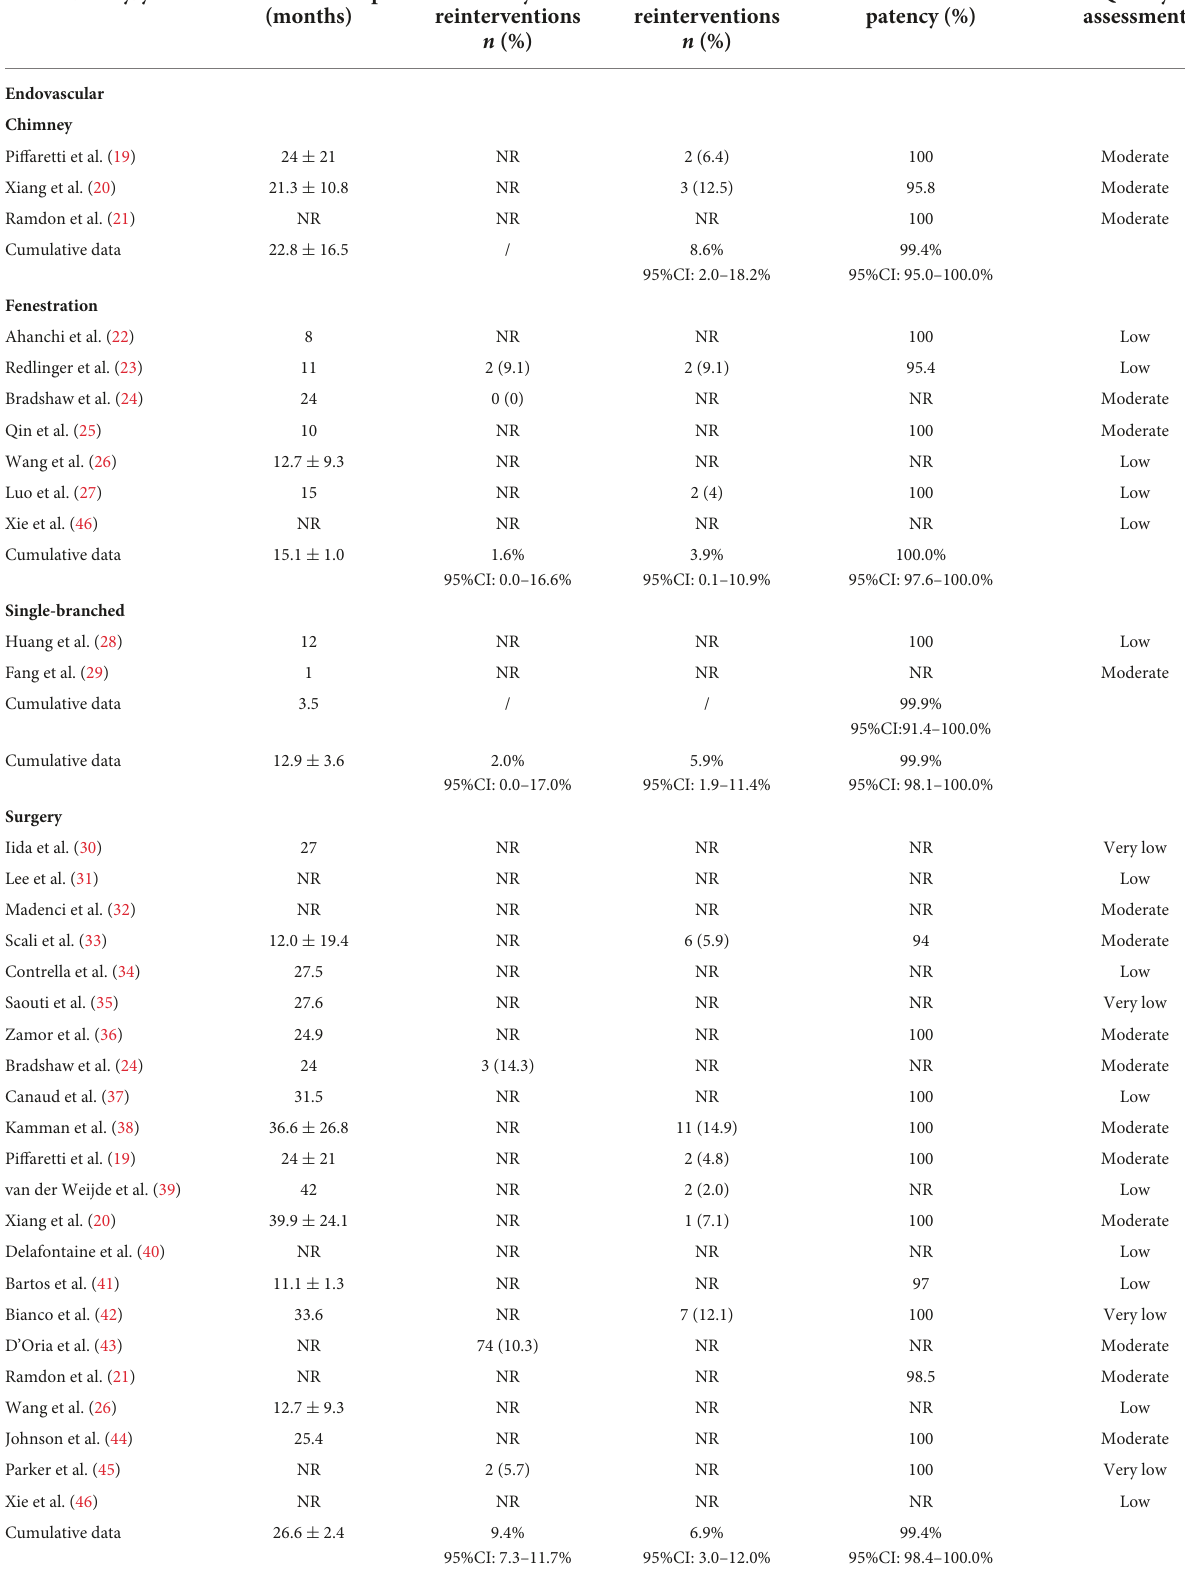
TABLE 2 Follow-up times, reinterventions and patency rates after endovascular revascularization and surgical